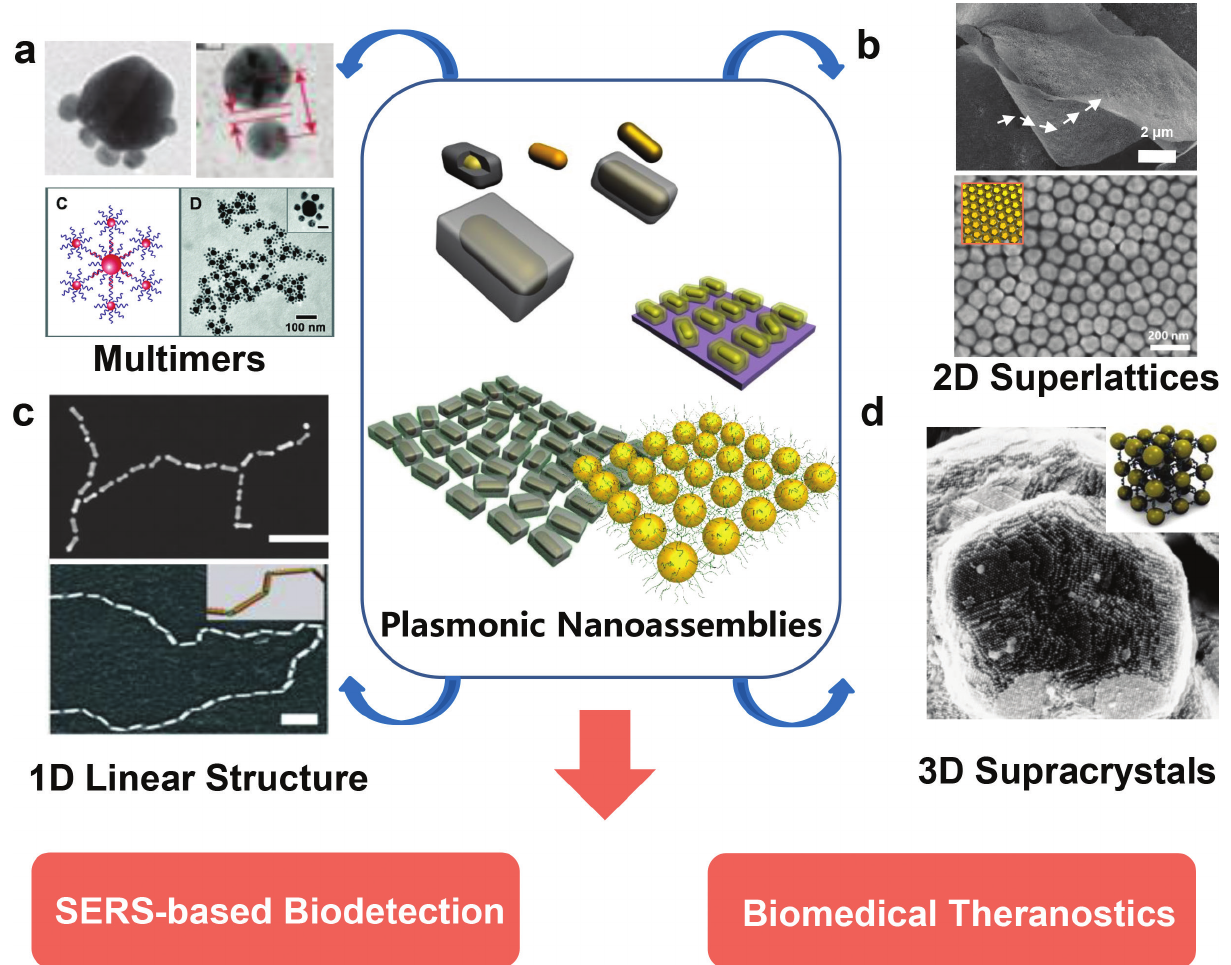
Fig. 1. Plasmonic nanoassemblies with multidimensional structures assembled from libraries of plasmonic atoms. (a) Plasmonic multimers (19–21). (b) 2D superlattice sheets (22, 23). (c) Linear and branch ‘polymeric chain’ assembled by Au nanorods (3, 4). (d) 3D Au nanoparticles (AuNPs) supracrystals controlled by DNA